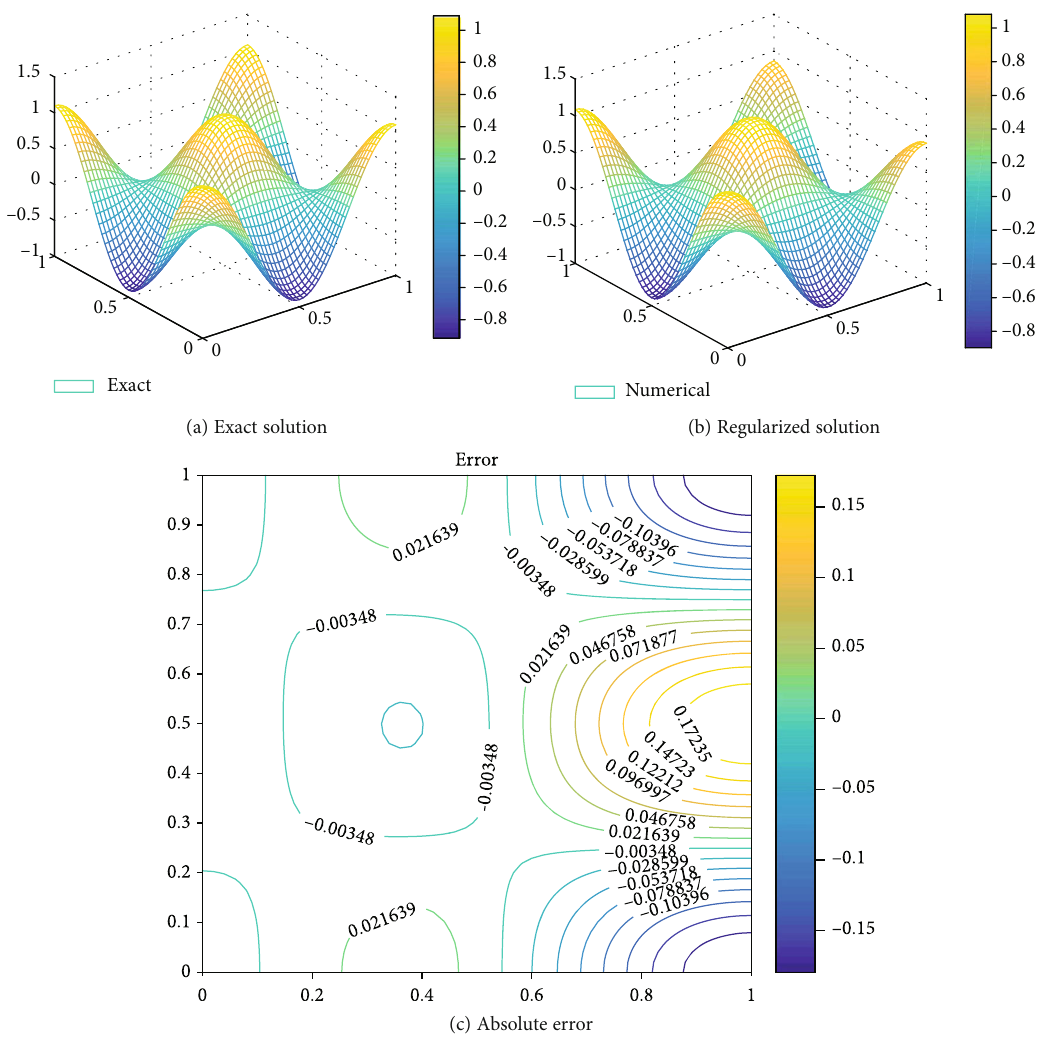
Figure 3: The numerical results for Example 18 for α = ð 0 : 9,0 : 5,0 : 1 Þ with μ = 0 : 01 δ 3/4